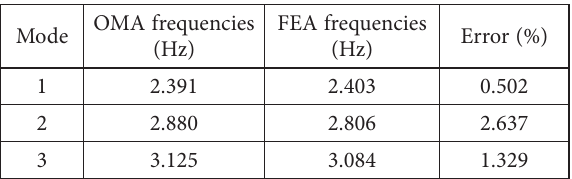
Table 3. Comparison between FEA and OMA frequencies OMA frequencies Mode